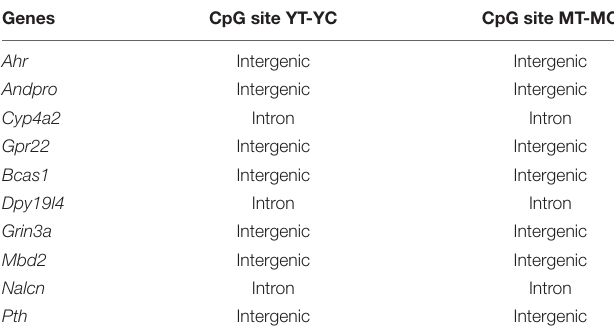
TABLE 1 | DNA structure exhibiting hypomethylation following E2-treatment in young and middle-age, but not older animals, for select genes linked to hormone response signaling.